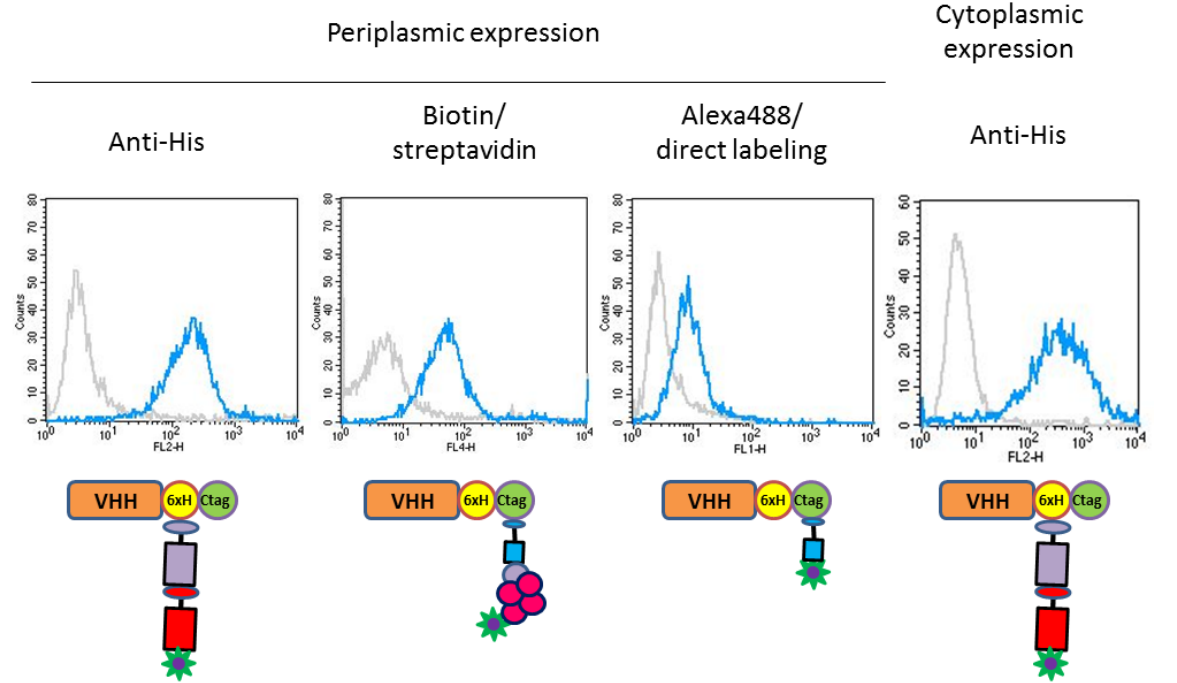
Figure 4. FACS analyses performed with C tagged recombinant antibodies. HER2 detection on MCF10A (neg) and SKBR3 (pos) cells was obtained using the anti-HER2 His+C-tagged A10 VHHs produced either in bacterial periplasm or cytoplasm in combination with: (i) an anti-His primary antibody (TeBu Bio) plus a PE goat anti-mouse secondary antibody (BD Pharmingen); (ii) the anti-C tag nanobody coupled to biotin plus APC-labeled streptavidin; (iii) an Alexa488-labeled anti-C tag nanobody.